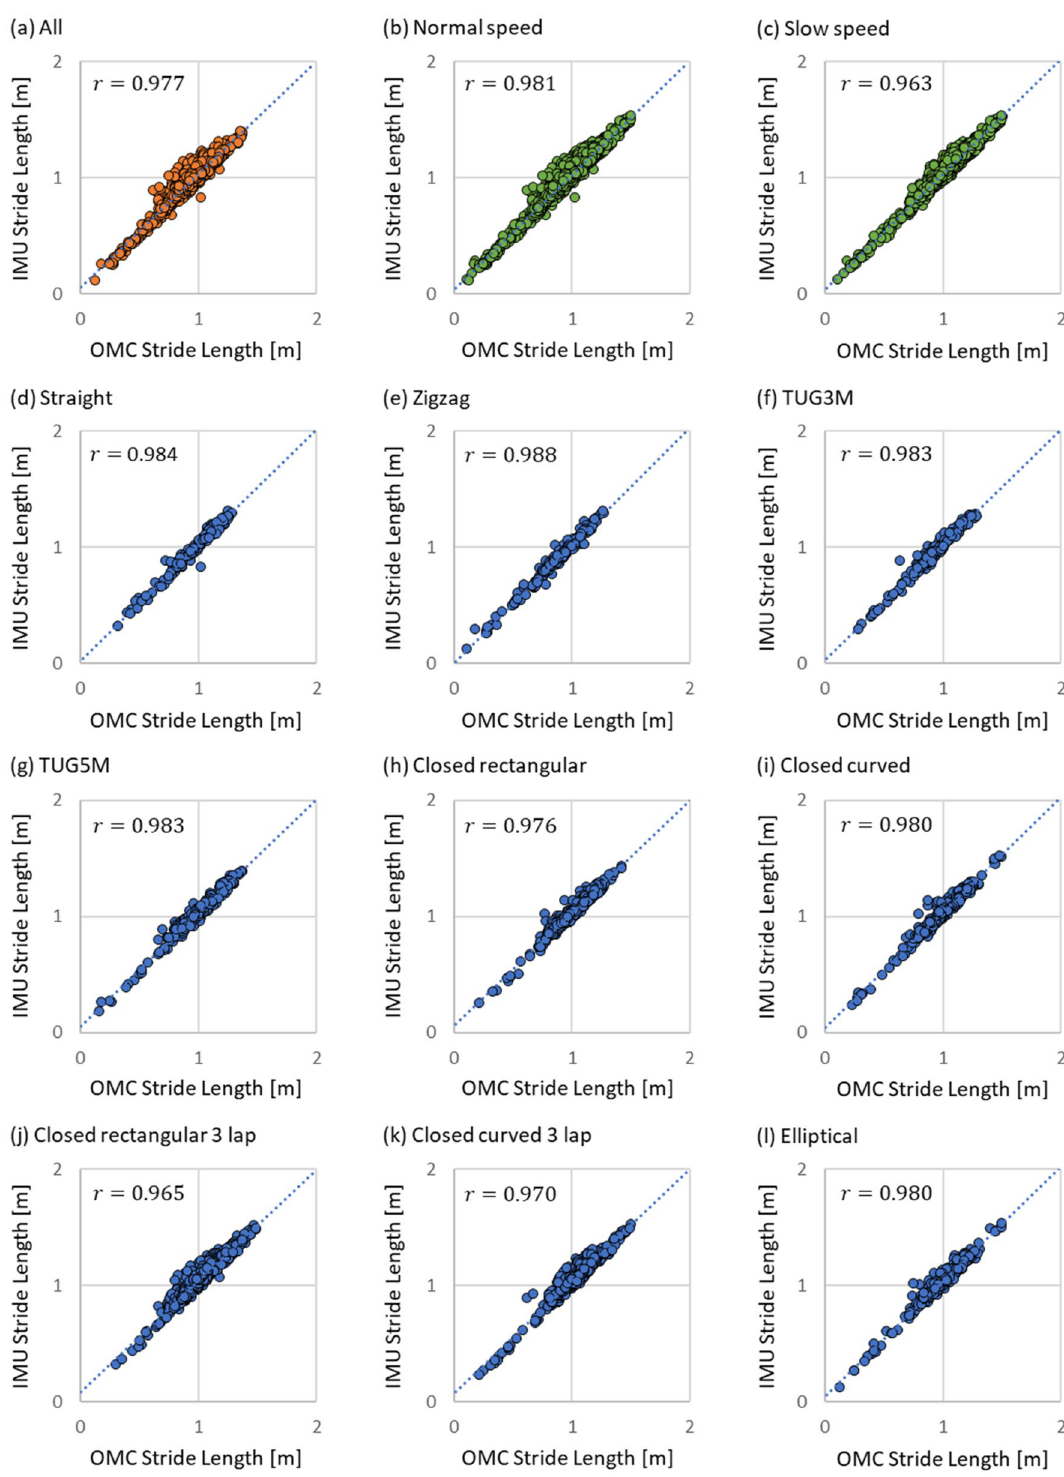
Figure 2. Results of Pearson’s product ratio correlation analysis between the proposed method and golden standard in stride length. These results were evaluated for the two walking speed conditions and nine walking route conditions. IMU means the proposed method and OMC means the golden standard as the ground